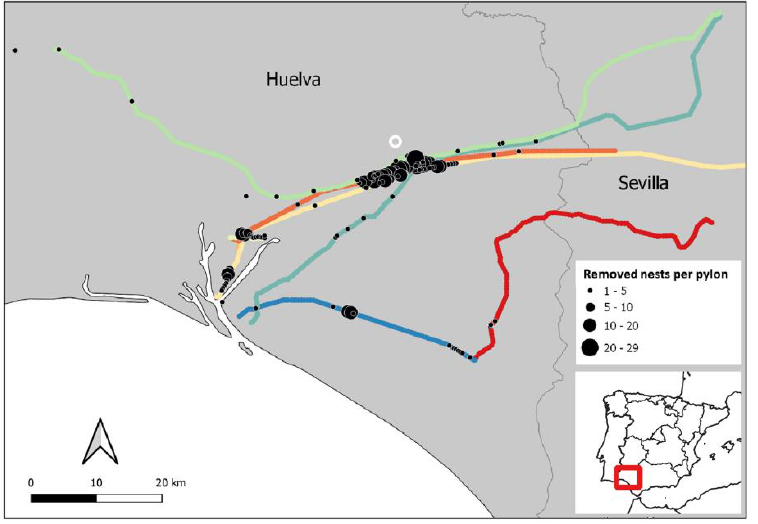
Figure 1. Geographical location of the 475 km of eight transmission powerlines (220–400 kV; color lines) included in this study, and number of nests removed per intervened pylons (black dots) of the lines during the period 2016–2019, in the Spanish provinces of Huelva and Seville (Spain). Location of the Buenavista landfill is also included (white circle).